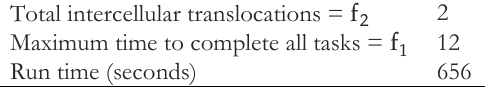
Table 6. Output information of objective functions.